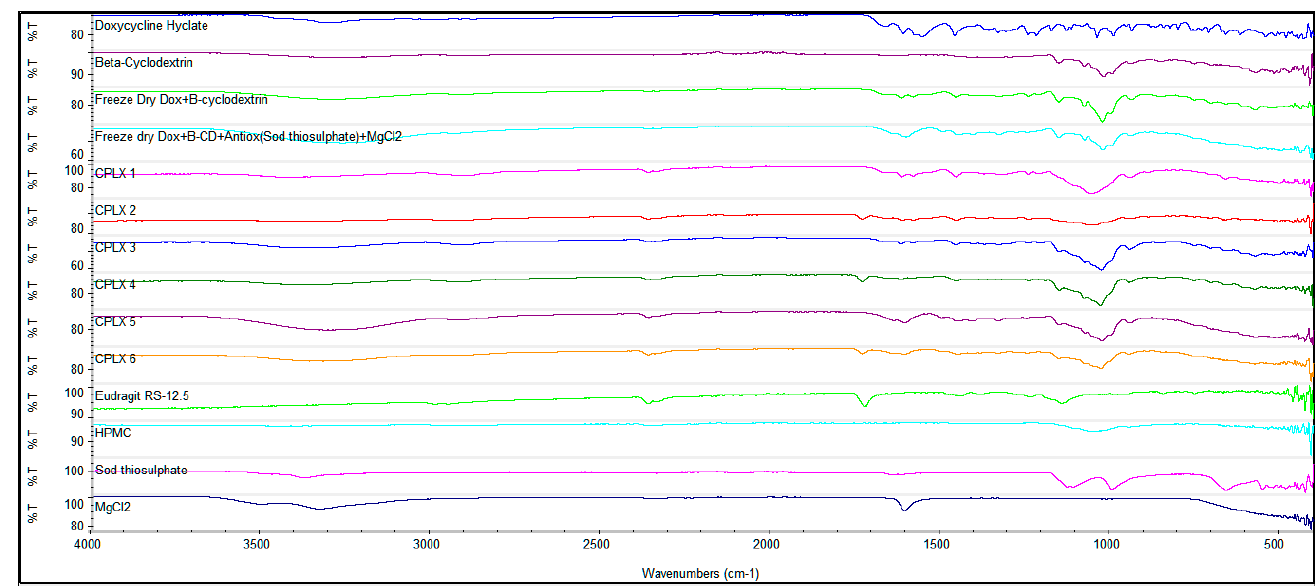
Figure 1. Fourier-transform infrared spectroscopy (FTIR) analysis of the following compounds. CPLX1 = doxycycline in 2% HPMC solution; CPLX2 = doxycycline in 2% HPMC solution with 0.25% Eudragit ® RS 12.5; CPLX3 = doxycycline and β -cyclodextrin in 2% HPMC solution; CPLX4 = doxycycline and β -cyclodextrin complex in 2% HPMC solution with 0.25% Eudragit ® RS 12.5; CPLX5 = doxycycline, β -cyclodextrin, sodium thiosulfate and MgCl 2 complex in 2% HPMC; CPLX6 = doxycycline, β -cyclodextrin, sodium thiosulfate and MgCl 2 in 2% HPMC with Eudragit ® RS 12.5; Eudragit ® RS 12.5; HPMC; sodium thiosulphate and magnesium chloride.